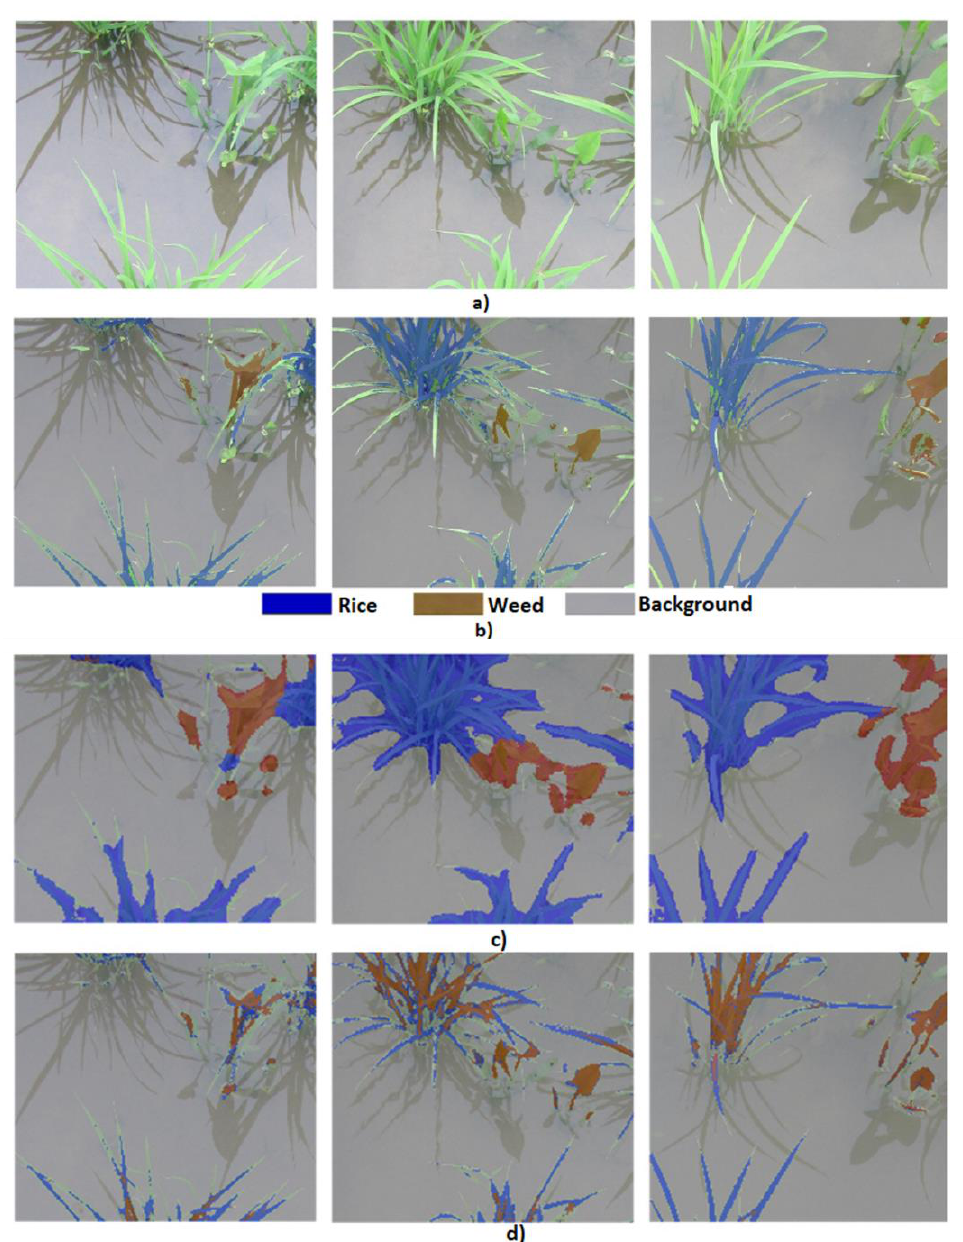
Figure 6. Results of the proposed model. ( a ) Original images; ( b ) Ground truth images; ( c ) Output by FCN; ( d ) Output by U-Net [29].